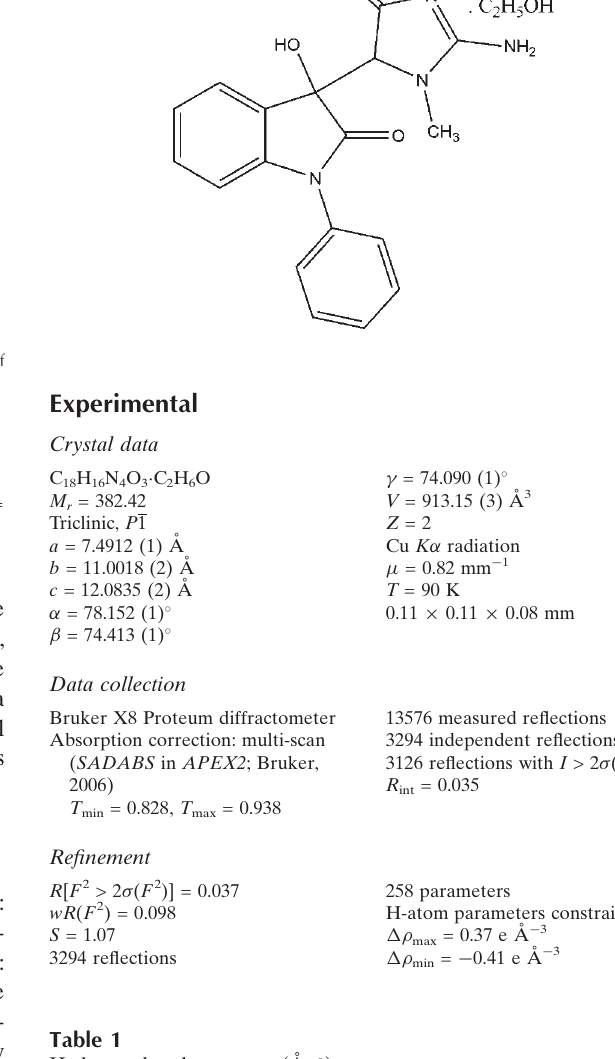
Hydrogen-bond geometry (A˚ , (cid:3) ). D —H (cid:2)(cid:2)(cid:2)